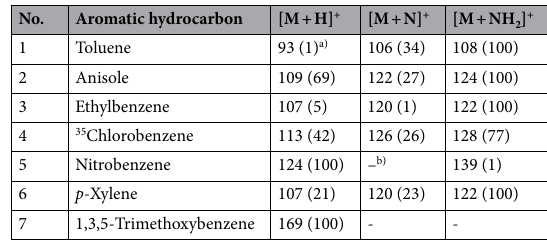
Table 2. Amination results of different substituted benzene analogues. a) m/z (relative abundance %). b) Relative abundance <